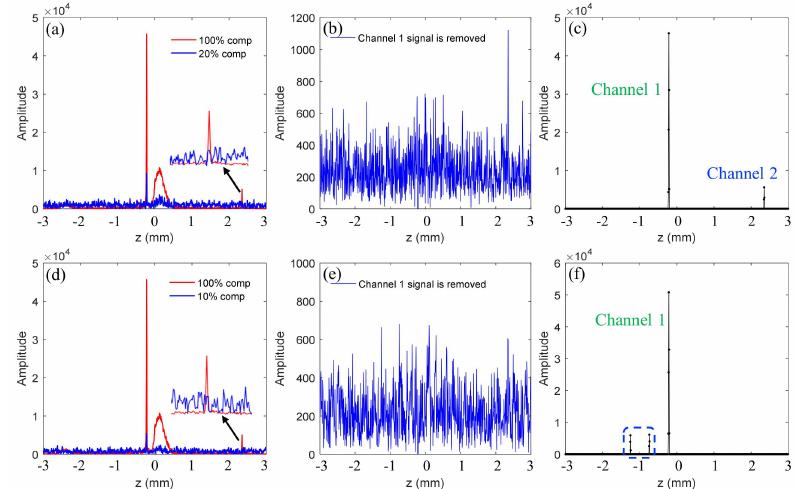
Figure 5. Experiment results of dual-channel SD-OCT system whose sample is a mirror. ( a )–( c ) The results are obtained by 20% spectral data; ( d )–( f ) the results are obtained by 10% spectral